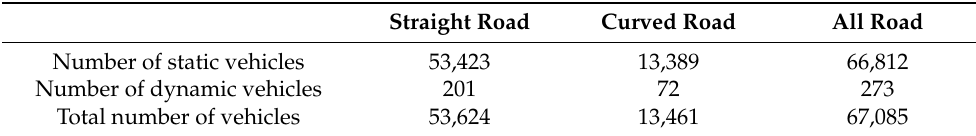
Table 3. The composition of SemanticKITTI dataset 00 sequences.